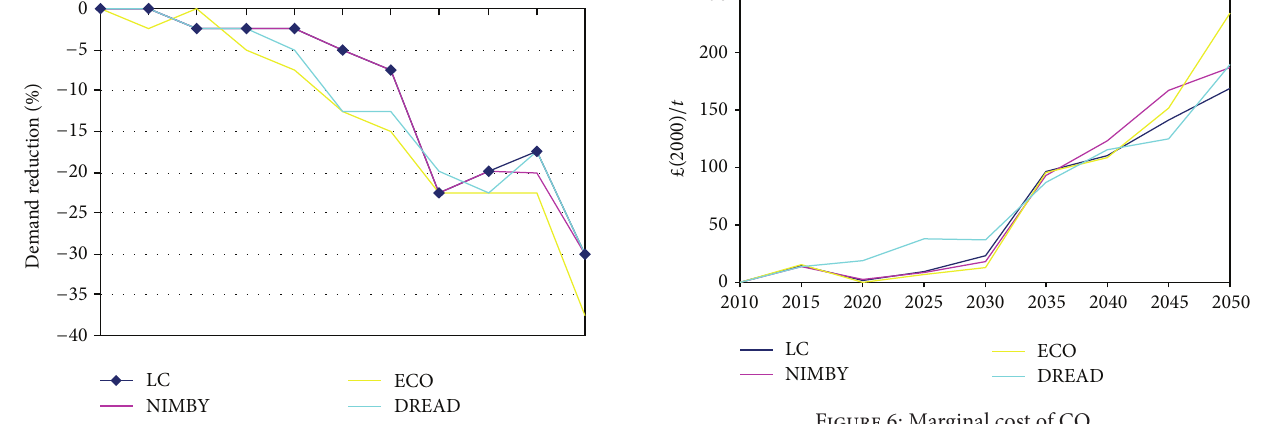
Figure 5: Residential gas demand reduction.